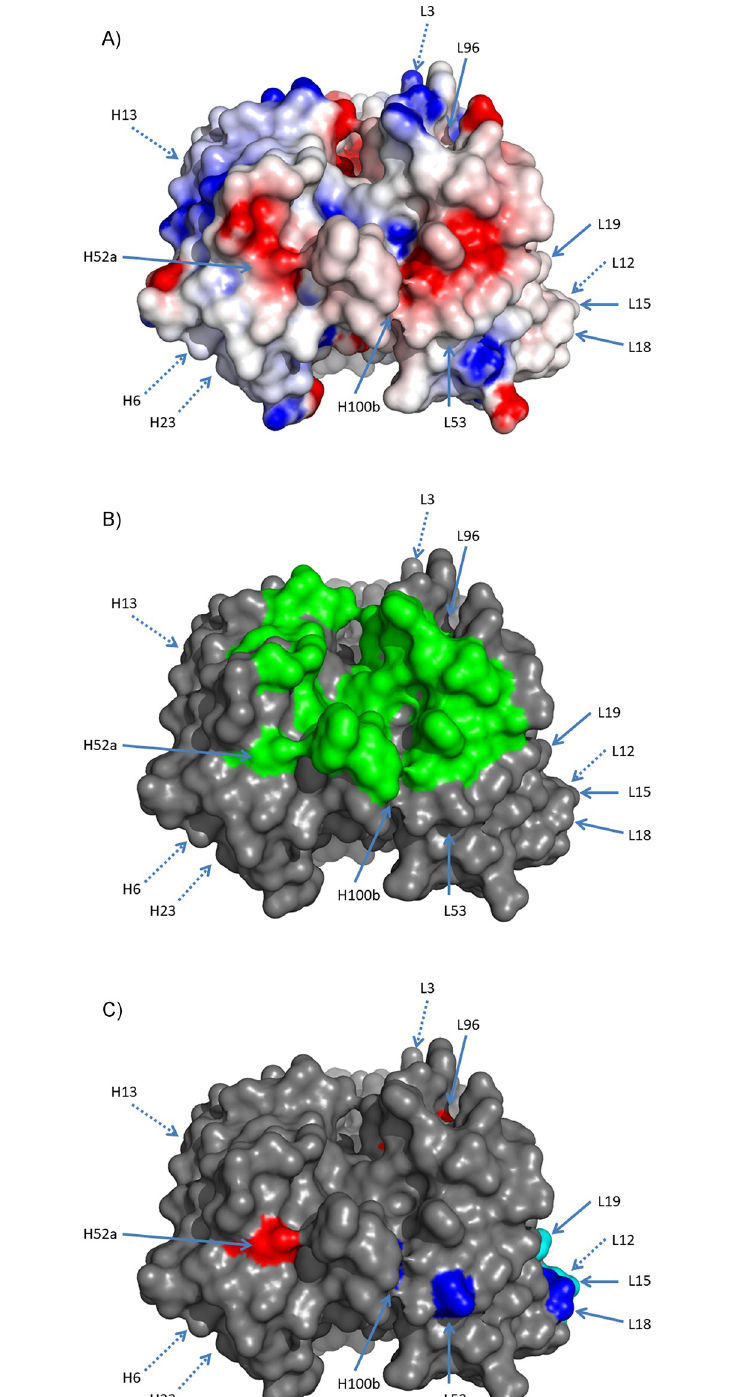
Fig 3. Round 1 design of viscosity reducing mutations. Mutations in round 1 were designed to reduce the overall negative charge and to reduce the negative charge patches. These patches were identified by generating an electrostatic potential energy surface using Delphi [30–32] seen in (a). Here red is negative charge potential and blue is positive charge potential. Mutations were also generated to avoid the interface residues (green) that are identified from the PDB structure 4qci and seen in (b). The mutants that were selected are shown in (c) where removal of negative charge sites is in red, addition of positive charge sites is in blue and the mutants for changing the FW1 to remove the clipped species are shown in light blue. All sites are annotated with Kabat